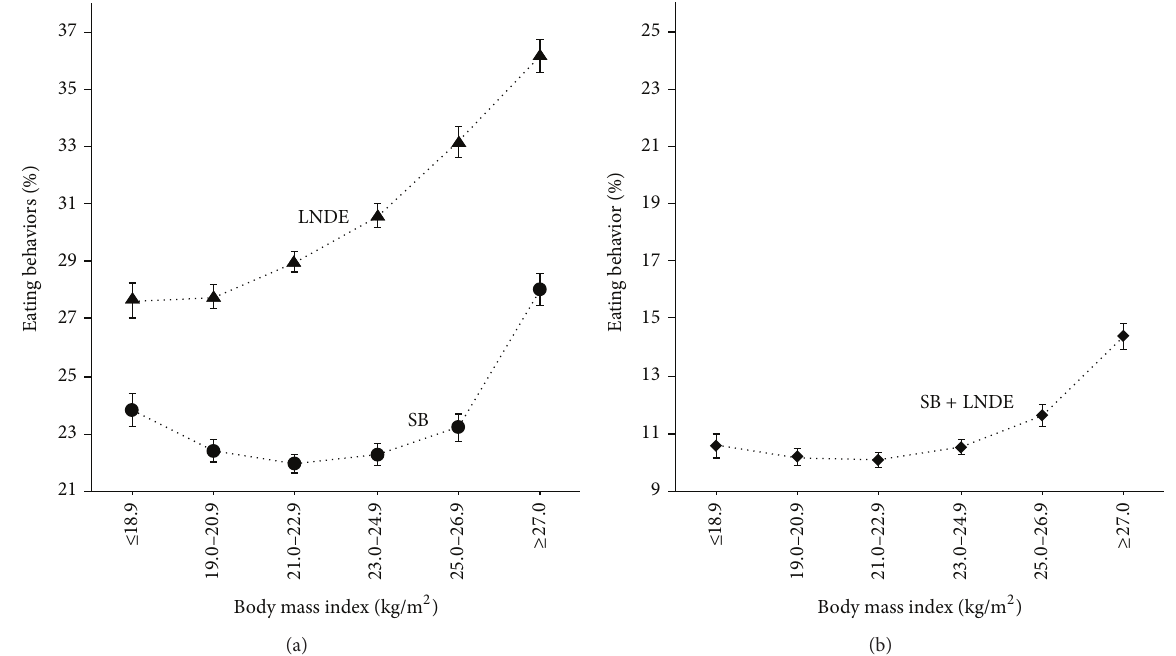
Figure 1: Proportions of subjects who skipped breakfast (SB) and with LNDE (a), and who skipped breakfast concomitant with LNDE (SB + LNDE), according to six body mass index (BMI) categories. The symbols in the middle of each bar represent the mean percentage of subjects with breakfast skipping, LNDE, or breakfast skipping concomitant with LNDE and was calculated as the number of subjects with these behaviors/number of subjects in each BMI group × 100, for each BMI category. The vertical bar represents the standard error (SEM) when skipping breakfast, LNDE, or skipping breakfast concomitant with LNDE was numbered as 1, and the absence of these behaviors as 0. Triangles ( 󳵳 ), circles ( e ), and diamonds ( Q ) represent overall breakfast skipping (SB), overall LNDE, and breakfast skipping concomitant with LNDE (SB + LNDE), respectively. The numbers of subjects in each of the six BMI categories from ≤ 18.9 to ≥ 27.0kg/m 2 were